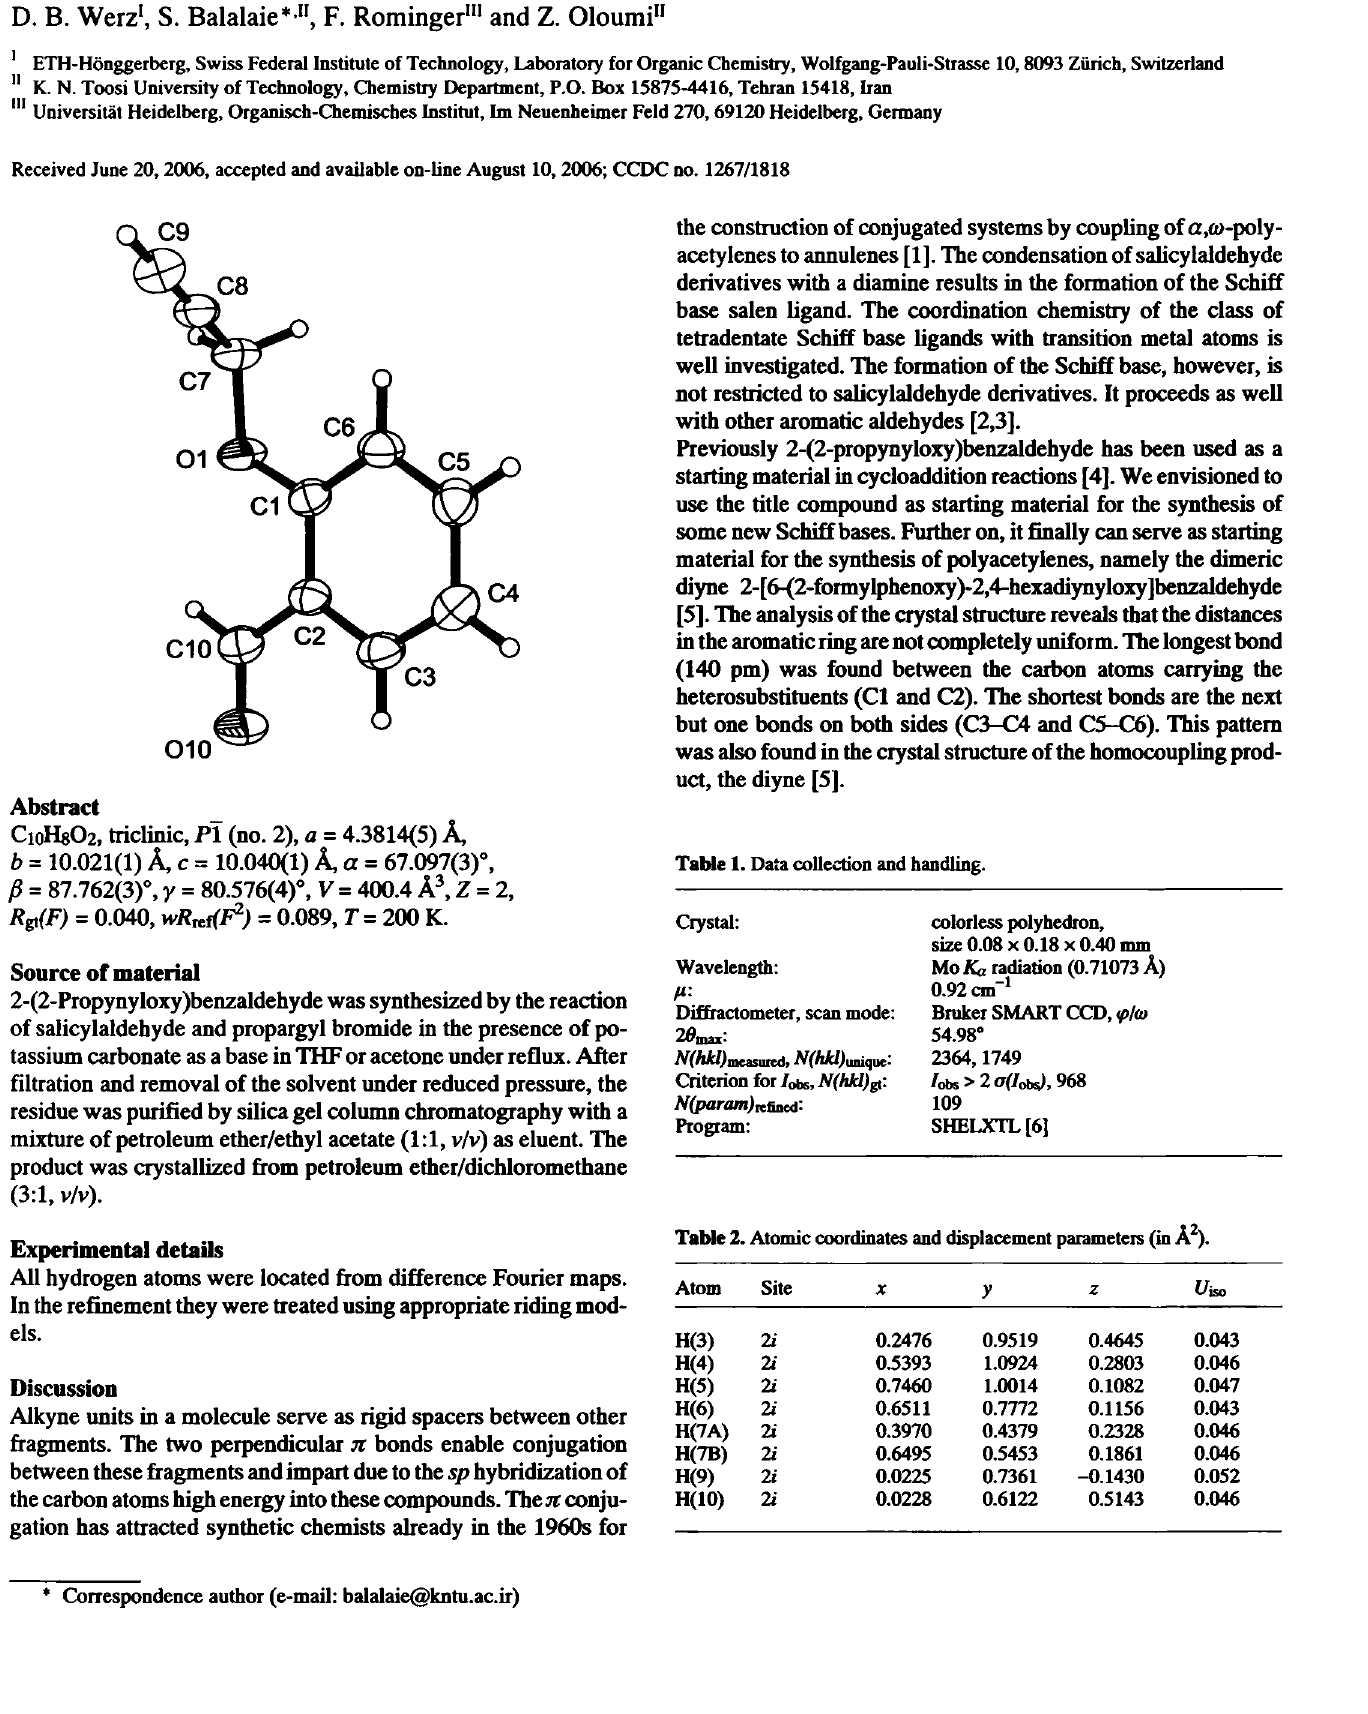
Table 2. Atomic coordinates and displacement parameters (in A 2